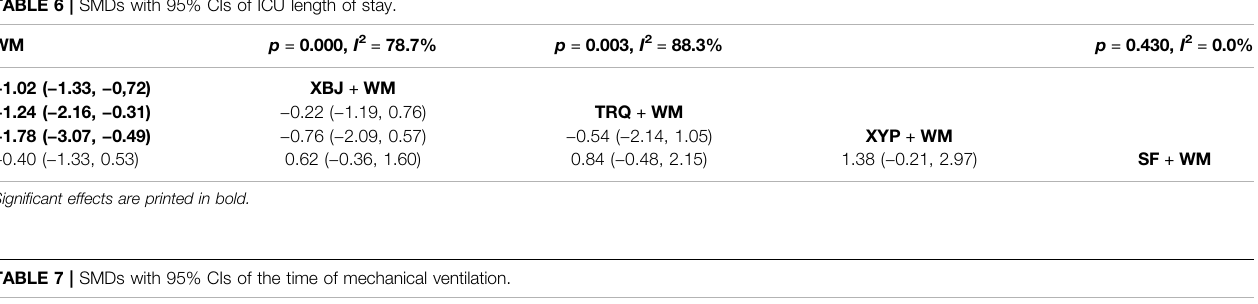
TABLE 7 | SMDs with 95% CIs of the time of mechanical ventilation. WM